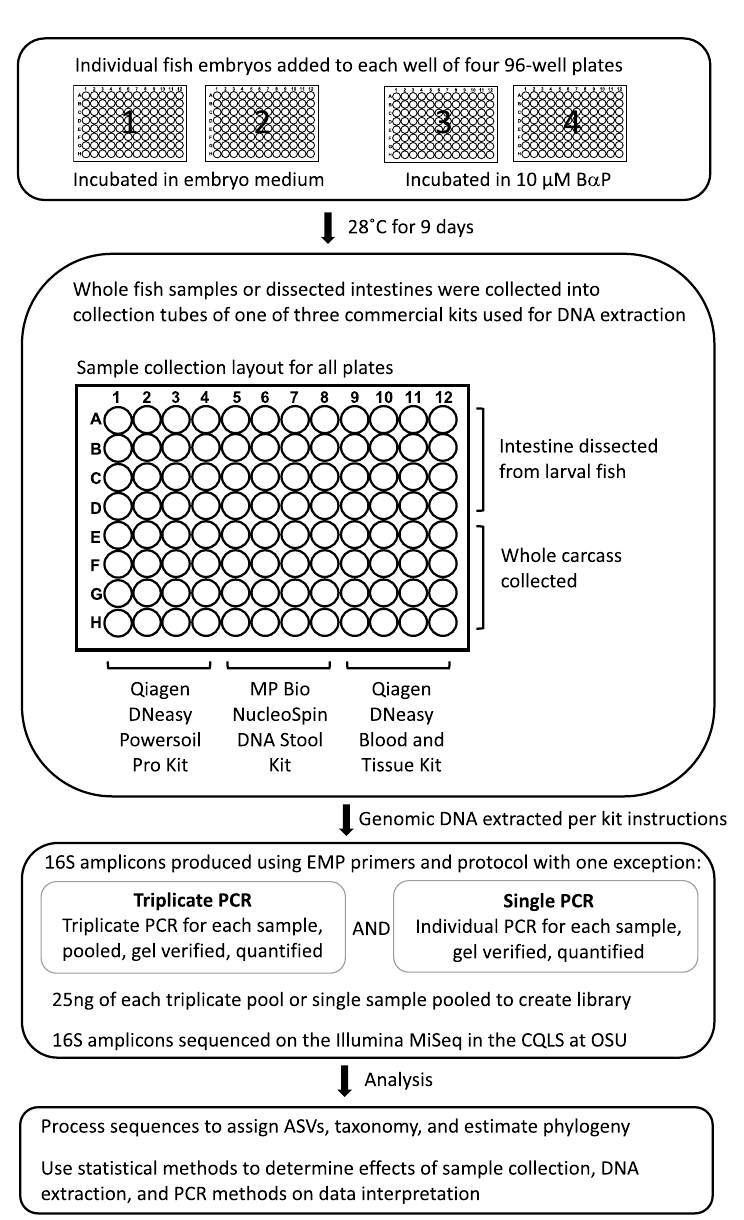
Figure 1. Experimental design. Overview of the methods analyzed for impact on interpretation of experimental results. First panel, 384 zebrafish larvae were distributed across the wells of four 96-well round-bottom plates. For two of these plates, the larvae were left untreated, while the larvae of the other two plates were exposed to 10 µM benzo-[a]-pyrene by way of their growth media. The zebrafish were raised in their wells on these plates until 9 days post fertilization. Second panel, for each of the four plates we conducted a fully factorial splitting of the samples by dissection method and DNA extraction kit. Half of the samples on each plate had their intestines dissected and placed in the collection tube, while for the other half, we placed the whole carcasses in their collection tubes. Then, in a manner orthogonal to dissection method, a third of each set of samples underwent DNA extraction using one of the three extraction kits. Third panel, we prepared 16S rDNA sequencing libraries using either single or triplicate PCR. Every sample was subject to both of these treatments. These libraries were then submitted for sequencing. Bottom panel, upon receiving the 16S sequences, we processed the data for quality and conducted the analyses described